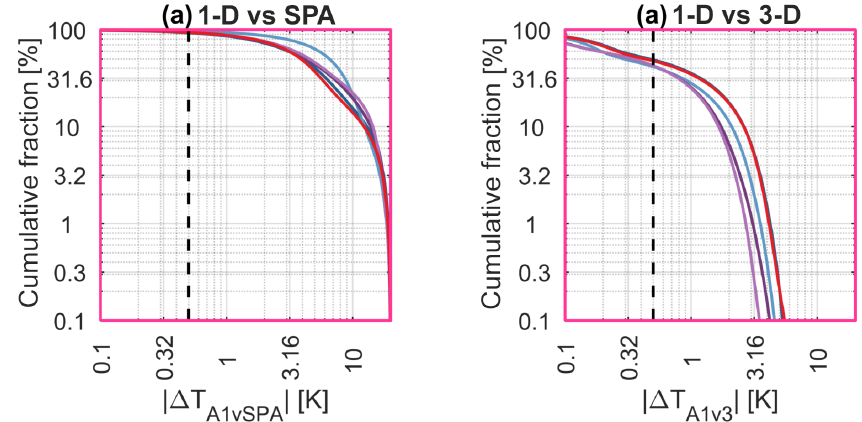
Figure C2. Cumulative distributions of the absolute difference (a) pseudo-1-D sampling and the SPA (b) pseudo-1-D sampling and full-3-D sampling. CFSR has been omitted since it only covers a small fraction of this